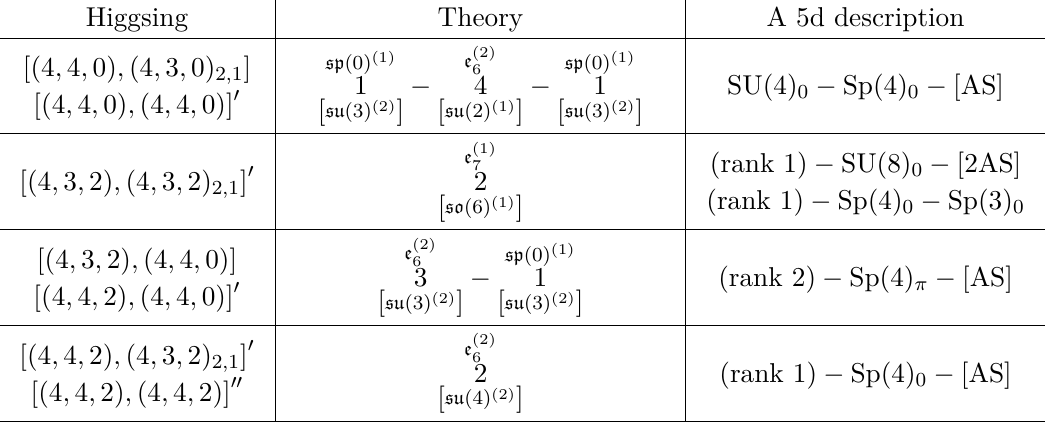
Higgsings associated to includes the cases where both ( a 1 , a 2 , a 3 ) and ( b 1 , b 2 , b 3 ) Higgs the e (1) which are not listed in this table can be obtained by the rule